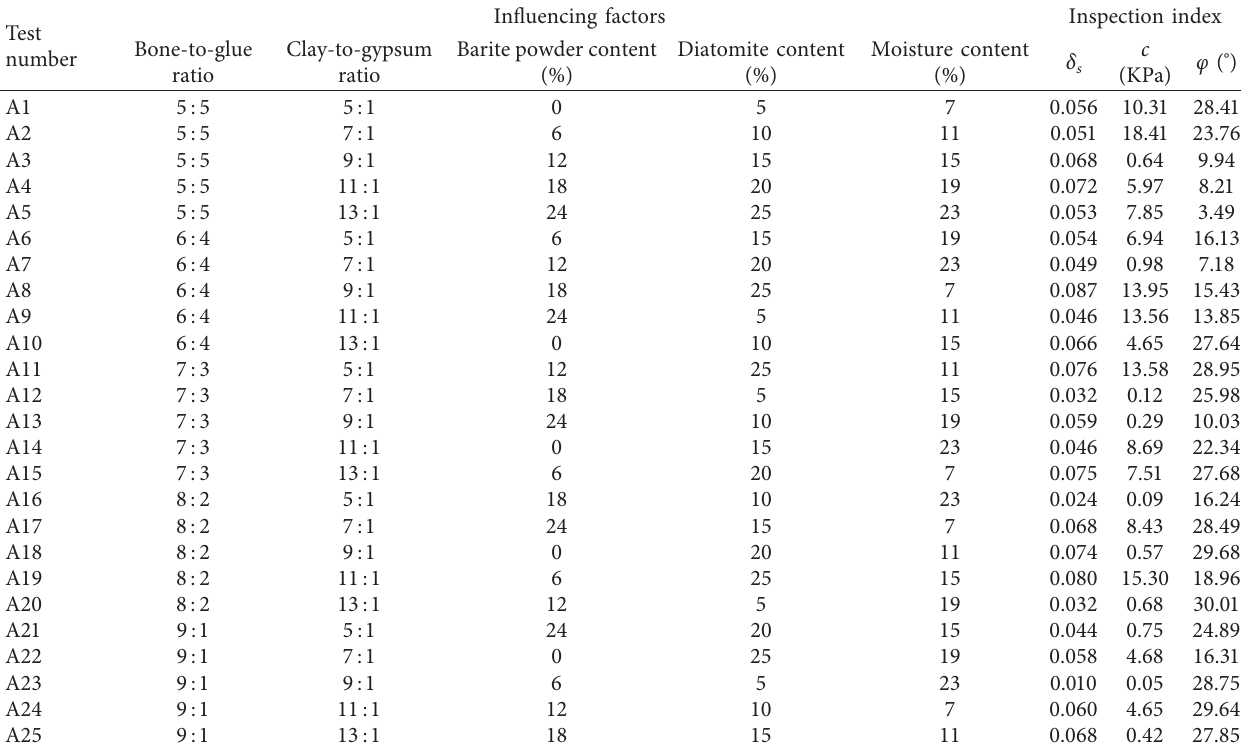
Table 2: Orthogonal test